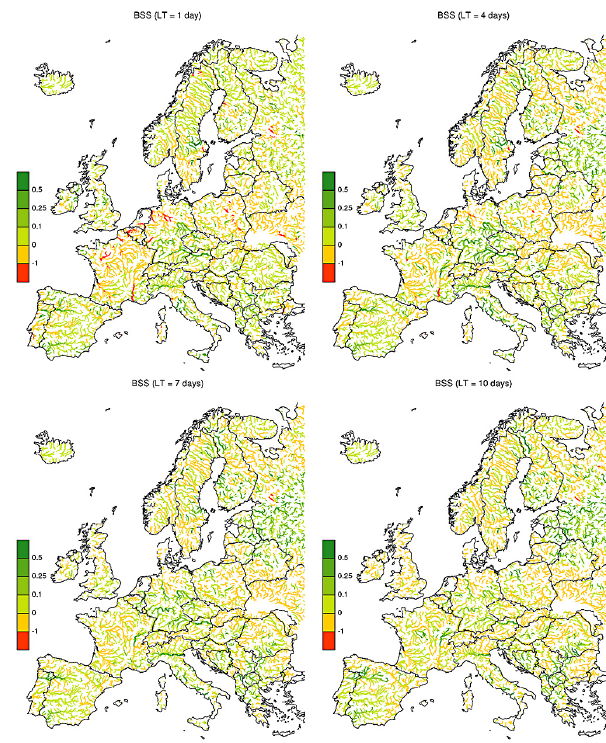
Figure 5. BSS of the ERI for lead times of 1, 4, 7, and 10days.